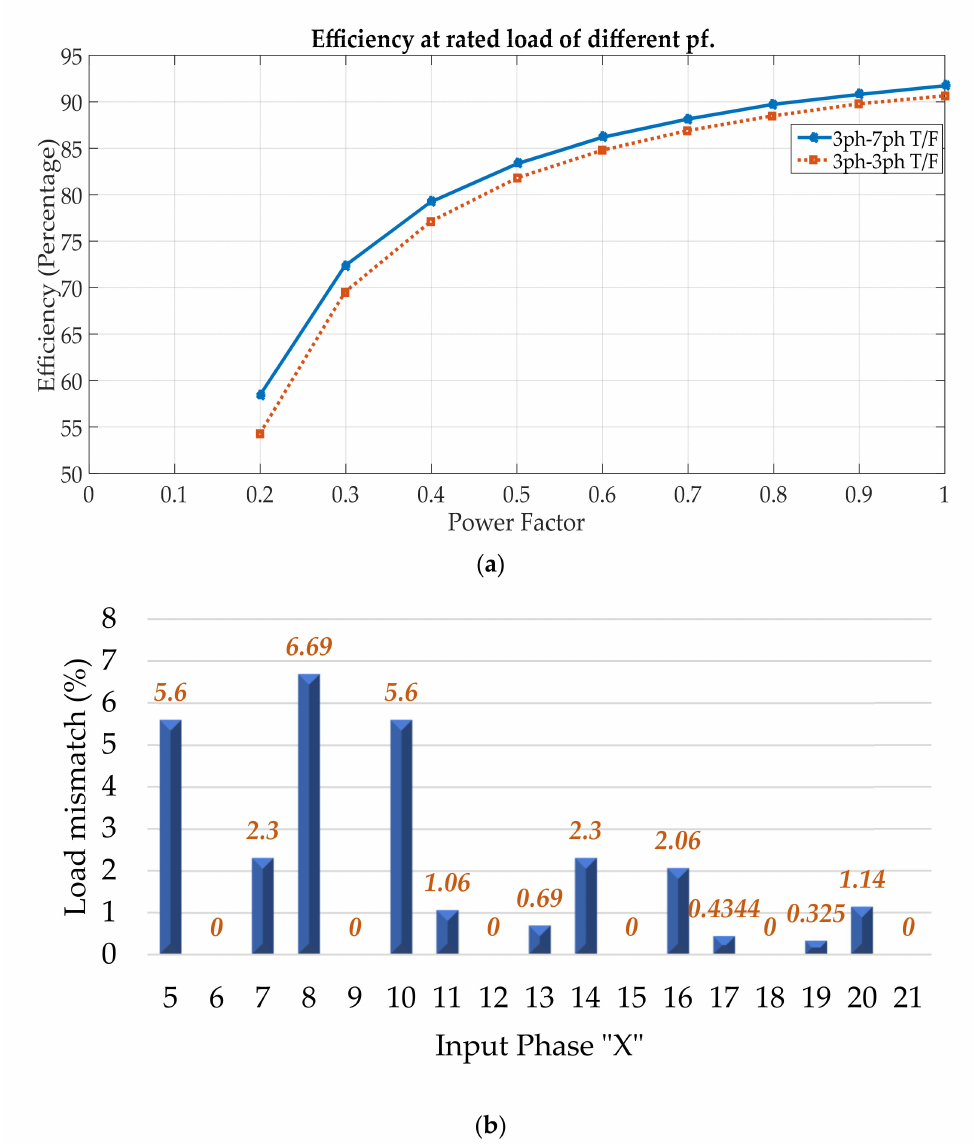
Figure 13. ( a ) Efficiency comparison of 3–7 and 3–3 transformers. ( b ) Impedance mismatch of an n -phase